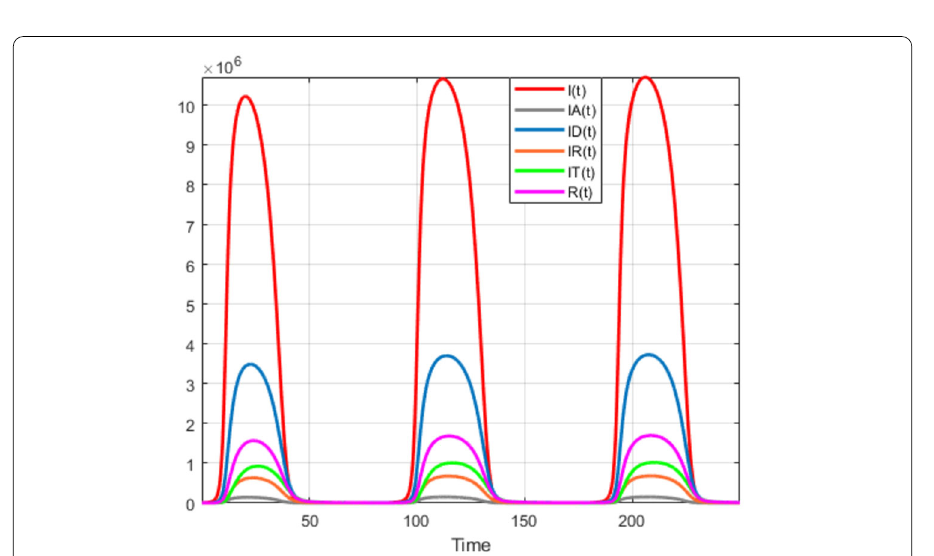
Figure 36 Numerical visualization of COVID-19 model for α = 0.89, β =